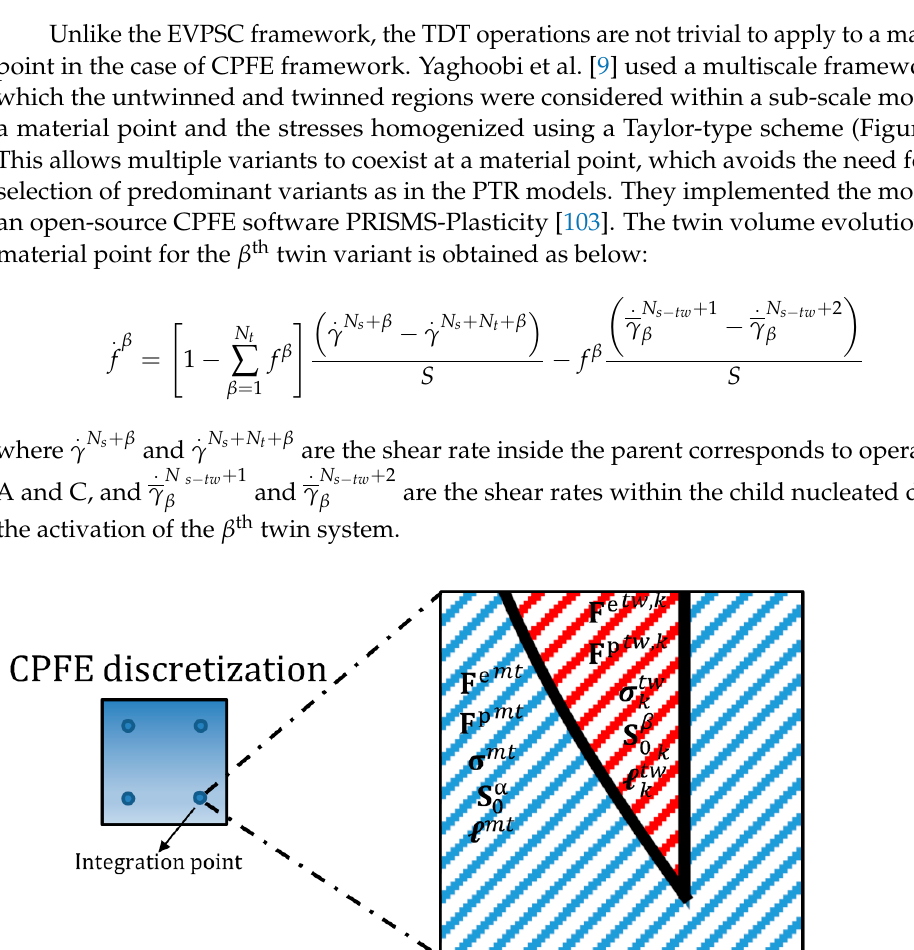
Figure 13. The comparison of the simulated stress ‐ strain response responses of ZK60A Mg alloy subjected to the uniaxial loading along the extrusion direction versus the experimental data of Wu [107] (Yaghoobi et al. [9]). 0100 200 300